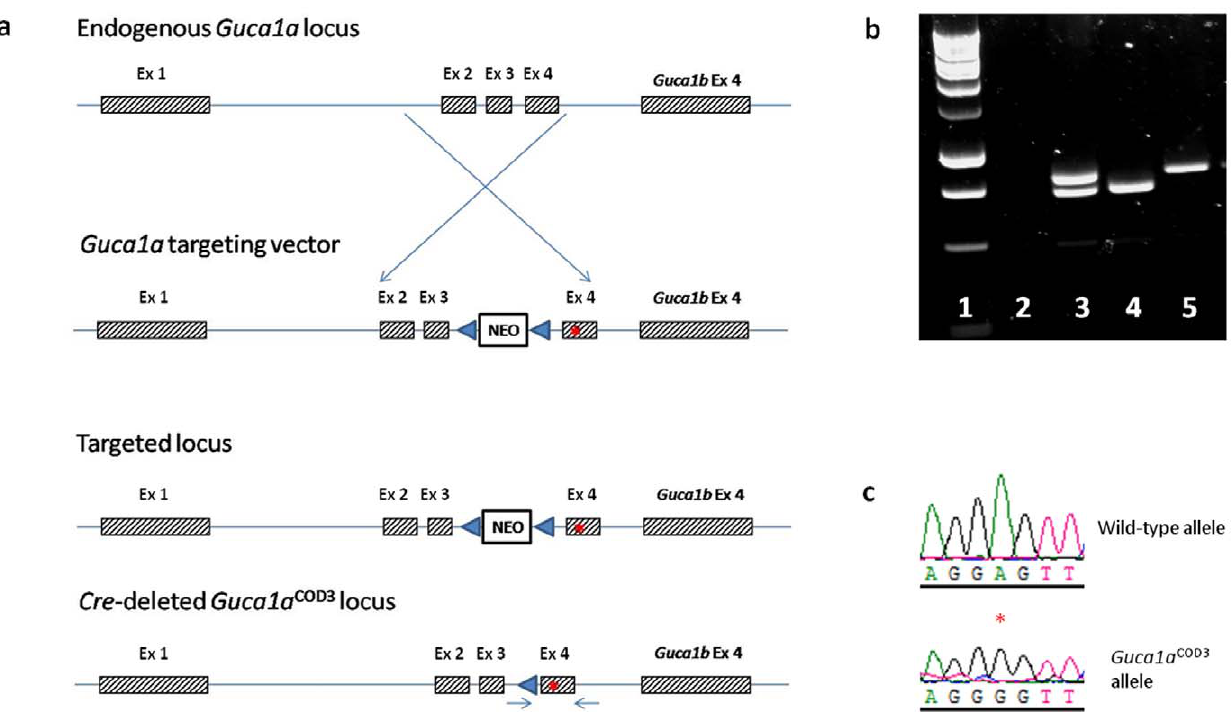
Figure 1. Generation of Guca1a COD3 ‘knock-in’ mice with E155G mutation in GCAP1. ( a ) A vector targeting the endogenous Guca1a locus was constructed to include an A-to-G transversion at nucleotide position 19 in exon 4 of Guca1a (red circle), as well as a loxP -flanked (blue arrow heads) neomycin resistance gene within intron 3. Following Cre -mediated excision of the Neo selectable marker, the resulting locus contained the A- to-G change in exon 4 plus a residual 34 bp loxP sequence in intron 3. This was used to distinguish between mutant and native alleles by PCR – the position of the primers used is indicated by the small blue arrows on the Cre -deleted Guca1a locus. ( b ) PCR amplicons from wild-type, Guca1a + /COD3 and Guca1a COD3/COD3 mice (lanes 3, 4 and 5 respectively), with 1 kb DNA ladder (lane 1) and no-DNA control (lane 2). The wild type allele generates a band at 734 bp whereas the mutant allele generates a 768 bp band which includes the residual intronic loxP sequence. Wild-type mice have therefore a single band at 734 bp, homozygous Guca1a COD3/COD3 mice have a single band at 768 bp, and heterozygous Guca1a + /COD3 mice have both bands. ( c ) Sequence of wild type and targeted Guca1a allele showing A-to-G transversion at nucleotide position 19 of exon 4.